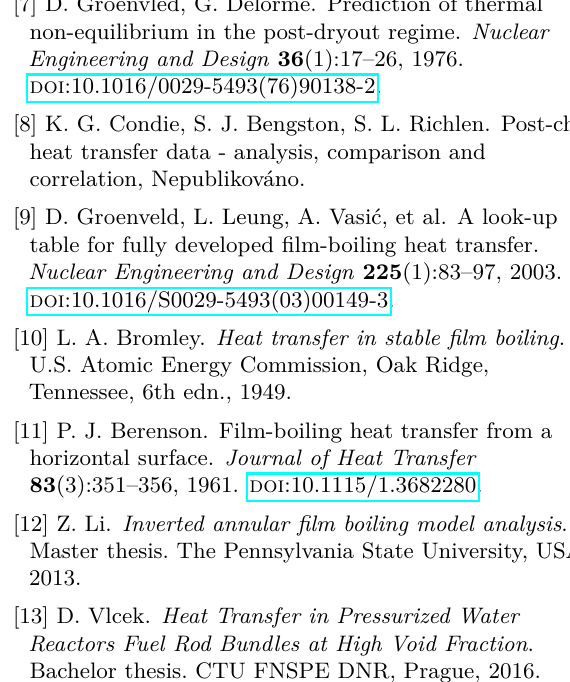
table for fully developed film-boiling heat